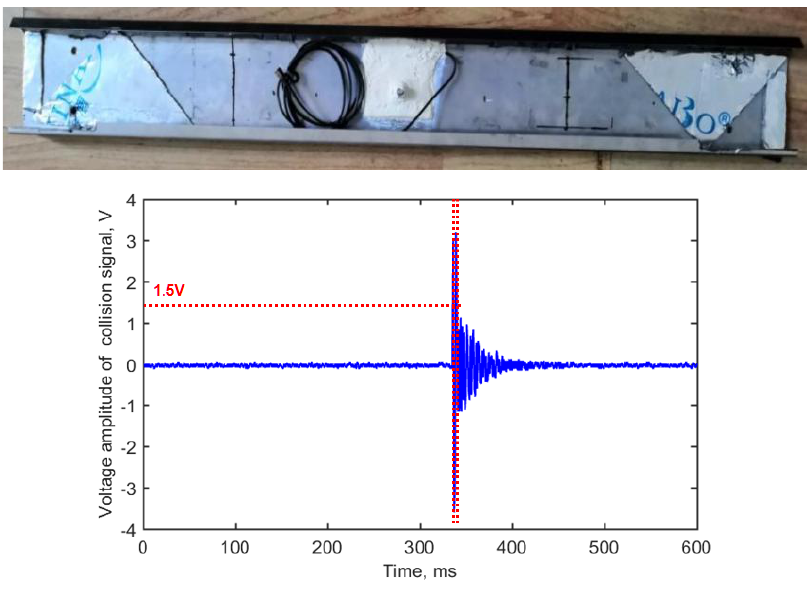
Figure 13. Collision signal when damping layer laid on the optimal position.